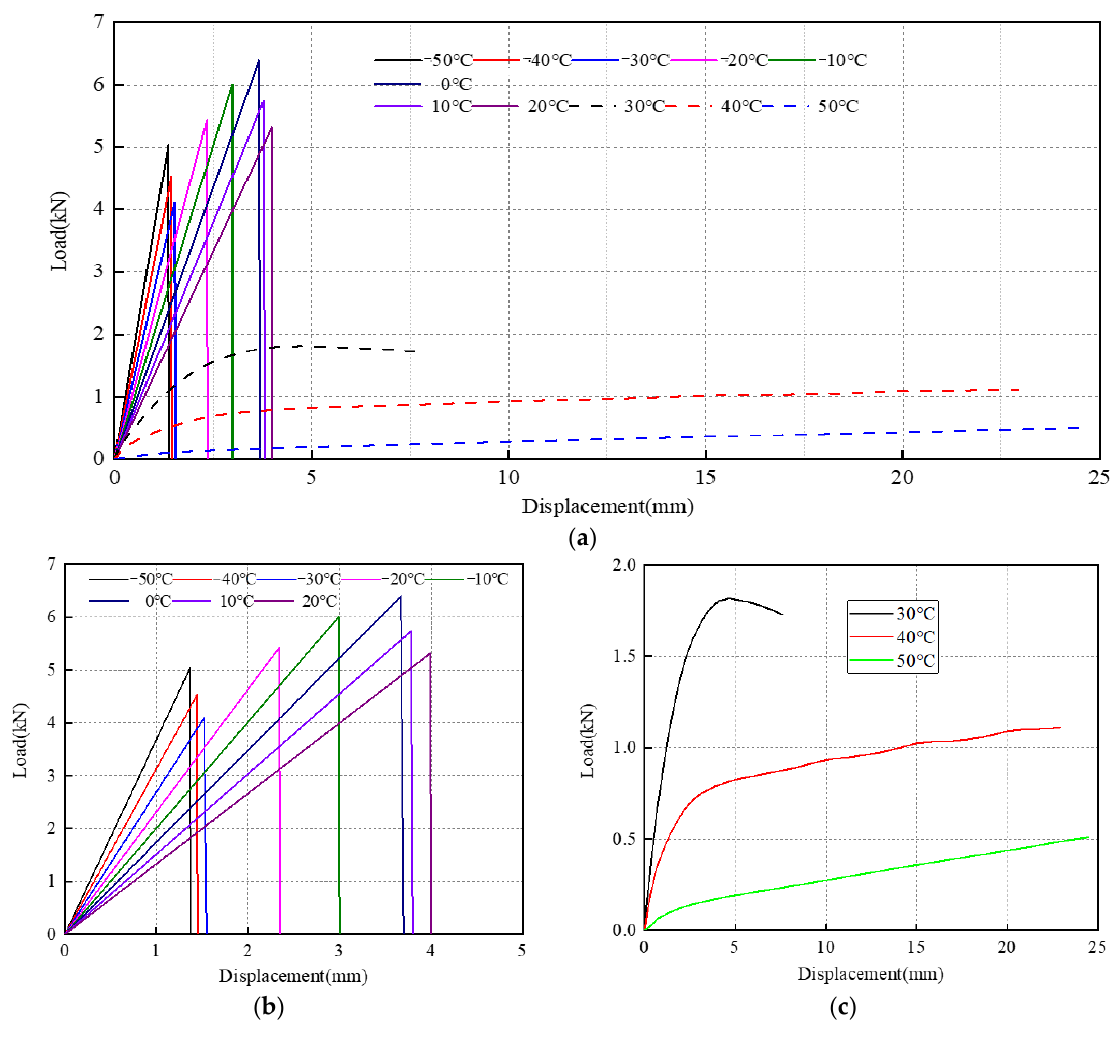
Figure 23. Load ‐ displacement diagram of polyurethane cement at different temperature levels: Figure 23. Load-displacement diagram of polyurethane cement at different temperature levels: ( a ) Load ‐ displacement curve for − 50°C~50 °C; ( b ) Load ‐ displacement curve below 20 °C (including ( a ) Load-displacement curve for − 50 ◦ C~50 ◦ C; ( b ) Load-displacement curve below 20 ◦ C (including 20 °C); ( c ) Load ‐ displacement curve above 20 °C. 20 ◦ C); ( c ) Load-displacement curve above 20 ◦